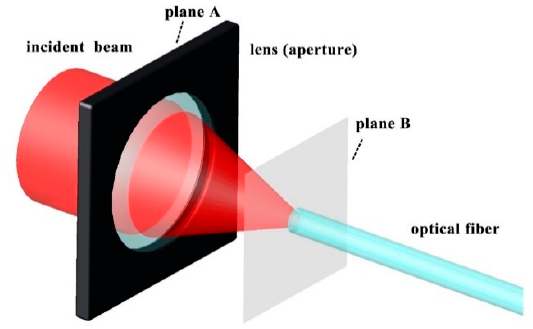
Figure 1. Illustrating notation related to the coupling of a beam into an optical fiber.